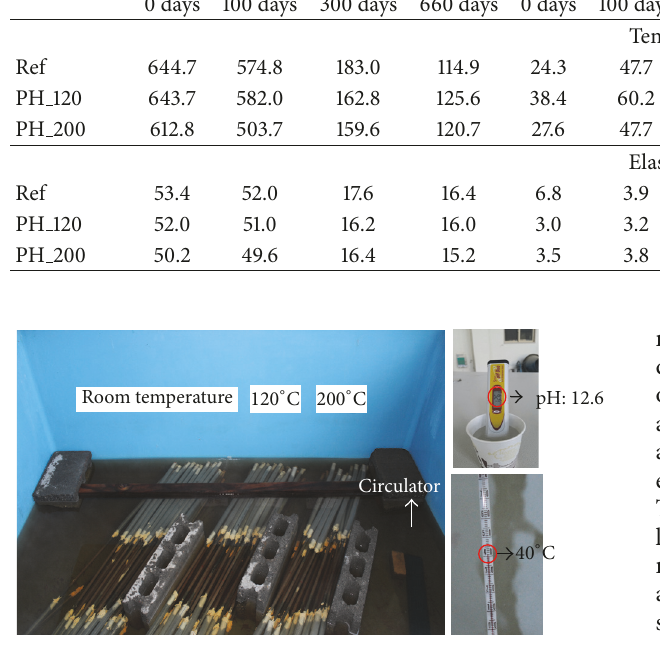
Figure 5: Immersion of GFRP rebar specimens into alkaline solu-